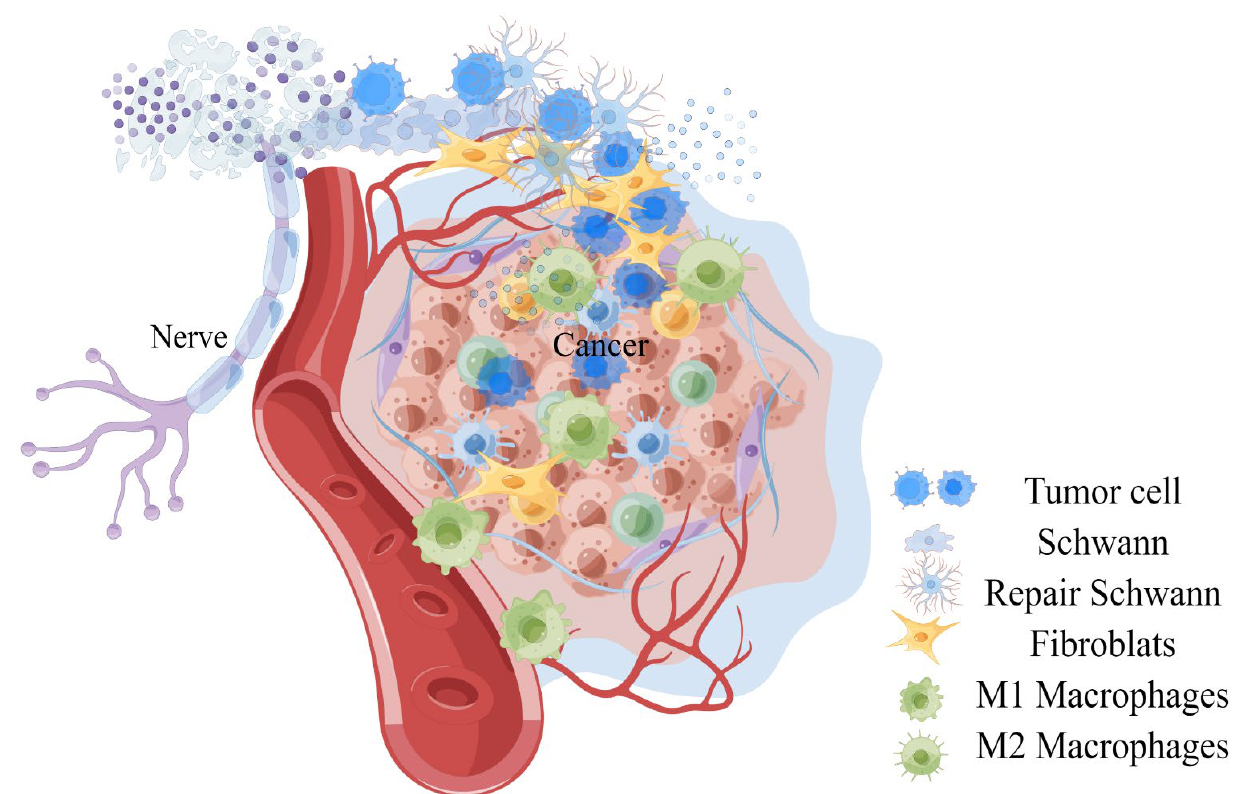
Figure 1. A general observation on the invasion of peripheral nerves of tumors. Table 1. Summary of factor function and its mechanism .